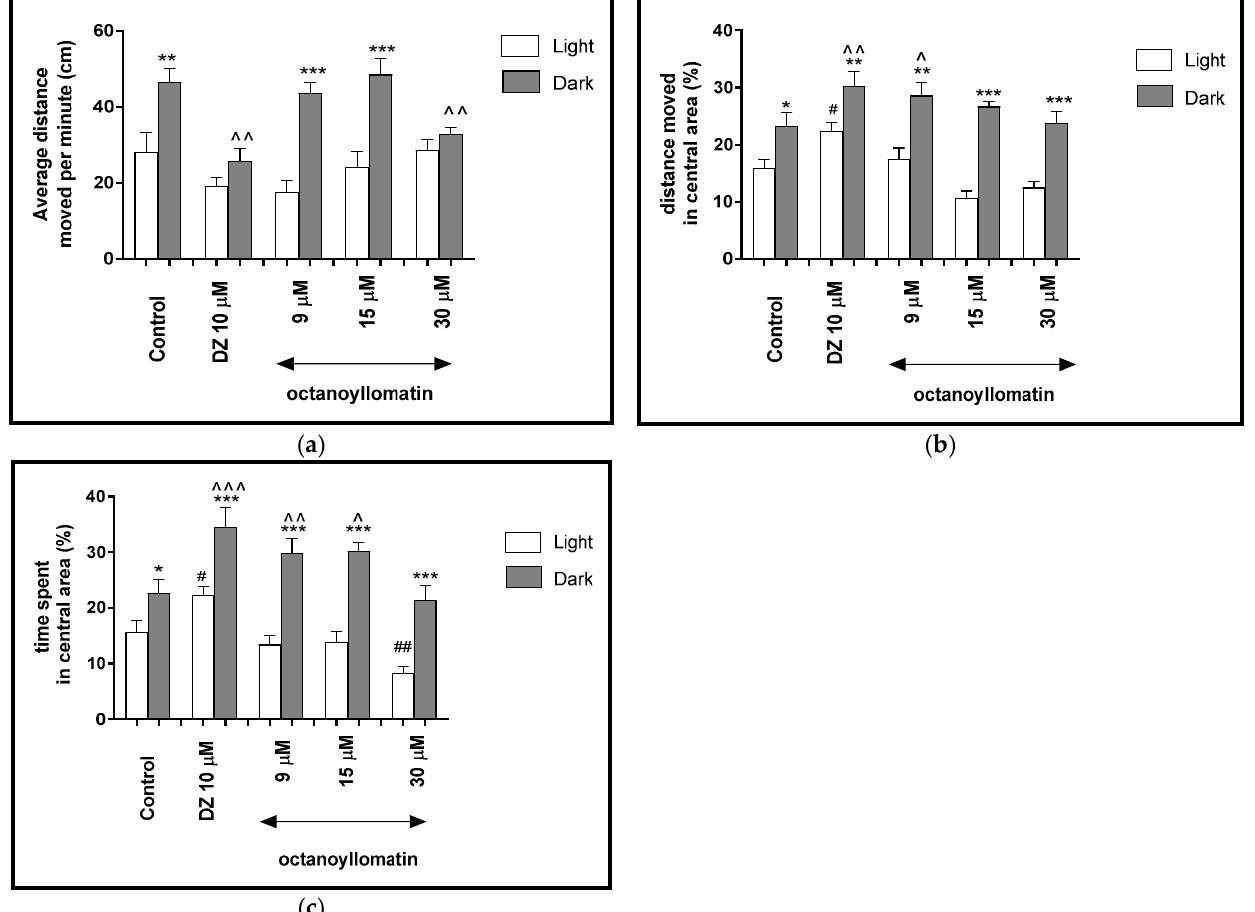
Figure 7. The effects of octanoyllomatin (9, 15 and 30 µM) and diazepam (DZ, 10 µM) on locomotor activity during all three light–dark challenge phase. ( a ) Average distance moved by zebrafish larvae within each 1-min time bin under either light (open bars) or dark (filled bars). ( b ) The percentage of distance moved by zebrafish larvae in the central area during light phase (white bars) or dark phase (filled bars). ( c ) The percentage of time spent by zebrafish larvae in the central area during light phase (white bars) or dark phase (filled bars). Data are presented as mean ± SEM; n = 32. * p < 0.05, ** p < 0.01, *** p < 0.001 in comparison to light conditions within the same concentration group; ^ p < 0.05, ^^ p < 0.01, ^^^ p < 0.001 in comparison to control group under dark condition; # p < 0.05, ## p < 0.01 in comparison to control group under light condition (post hoc Bonferroni’s